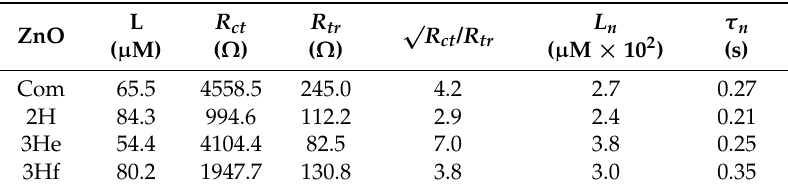
Table 2. An interfacial charge-transfer resistances ( R ct ), charge transport resistances ( R tr ), electron diffusion lengths ( L n ), and electron lifetimes ( τ n ) are derived from electrochemical characterization of the photoanodes under illumination. The same parameters under dark are demonstrated in Table S1 in supporting information.